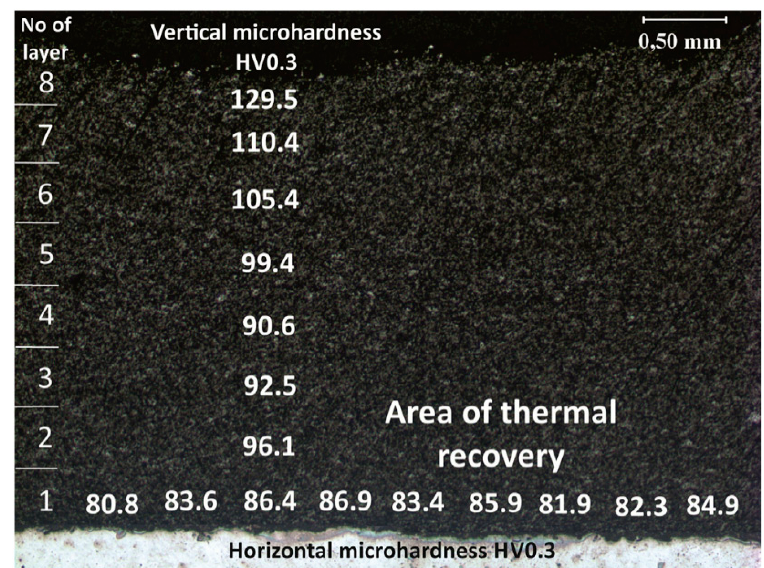
Figure 11. Microhardness distribution in the Al + Al 2 O 3 composite coating obtained by LPCS [126]. Reproduced with permission from [Archives of Civil and Mechanical Engineering], Elsevier, 2016.